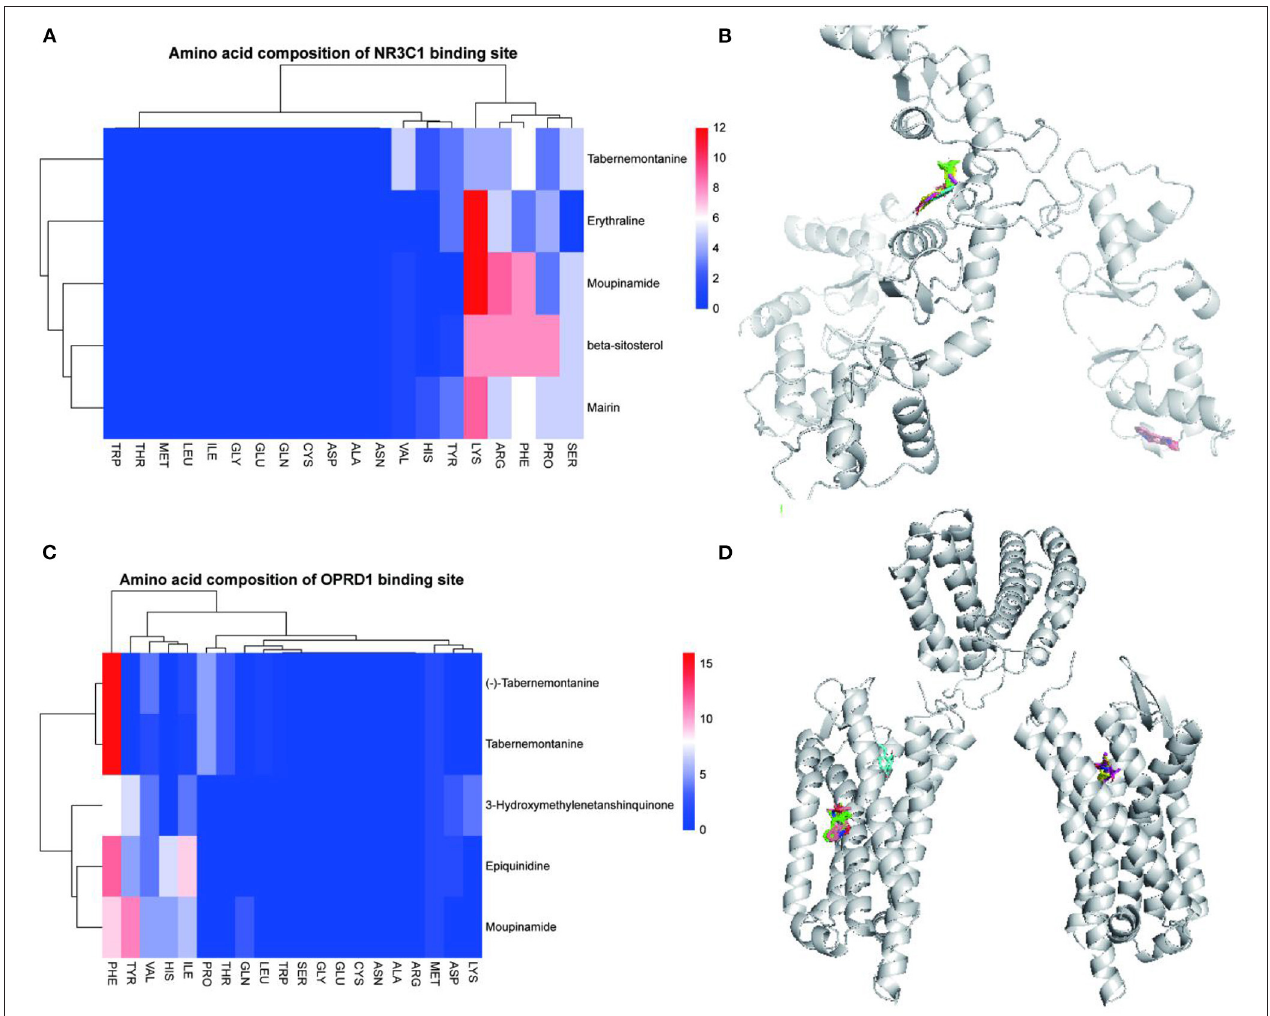
FIGURE 5 | Visualization of NR3C1 and OPRD1 molecular docking validation. Amino acid composition of NR3C1 binding site (A) ; Bulk molecular docking map of NR3C1 (B); Amino acid composition of OPRD1 binding site (C) ; Bulk molecular docking map of OPRD1 (D) .